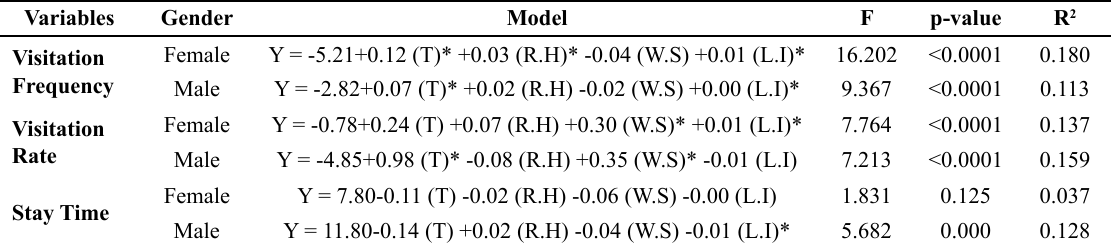
Table 3 . Multiple regression analysis between foraging behavior of female and male A. savignyi and environmental factors (T = Temperature, R.H = Relative humidity, W.S = Wind speed and L.I = Light intensity).